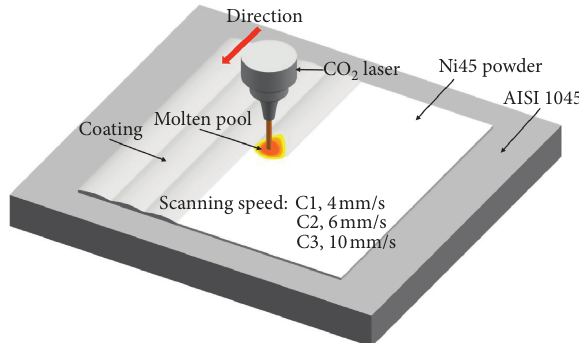
Figure 2: Schematic of the laser cladding process.